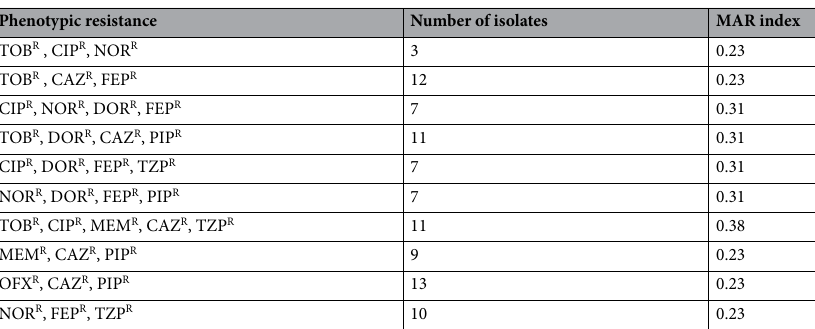
Table 3. Multidrug resistance profile of the P. aeruginosa isolates. TOB tobramycin; CIP ciprofloxacin; NOR norfloxacin; CAZ ceftazidime; FEP cefepime; DOR doripenem; PIP piperacillin; TZP piperacillin-tazobactam; MEM meropenem; OFX ofloxacin; IPM : imipenem; AMK amikacin; GEN